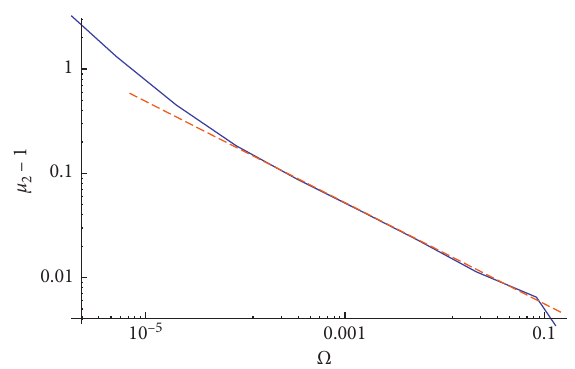
Figure 3: Scale-dependent variance of the projected stellar mass, with a power-law fit giving c � 1 .